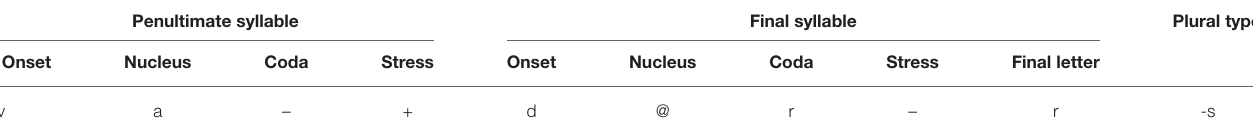
TABLE 2 | An example of a TiMBL feature vector and class label for the plural vaders “fathers”. Penultimate